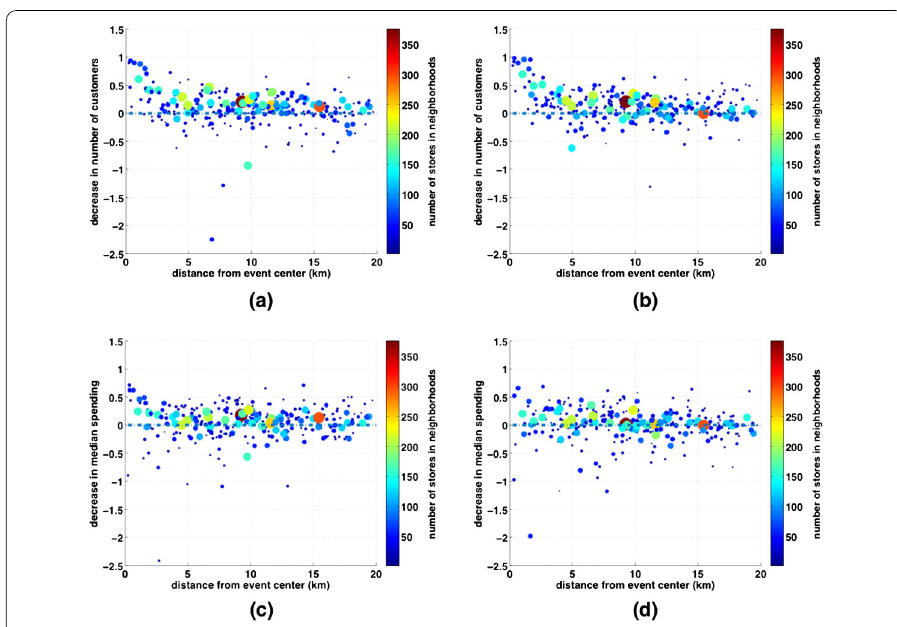
Figure A3 The decrease in the two behavioral indexes for neighborhoods that are located at different distances from the event center. ( a ) number of customers on Day 62; ( b ) number of customers on Day 77; ( c ) median spending on Day 62; ( d ) median spending on Day 77. Both the size and color of the circles indicate the number of stores in each neighborhood